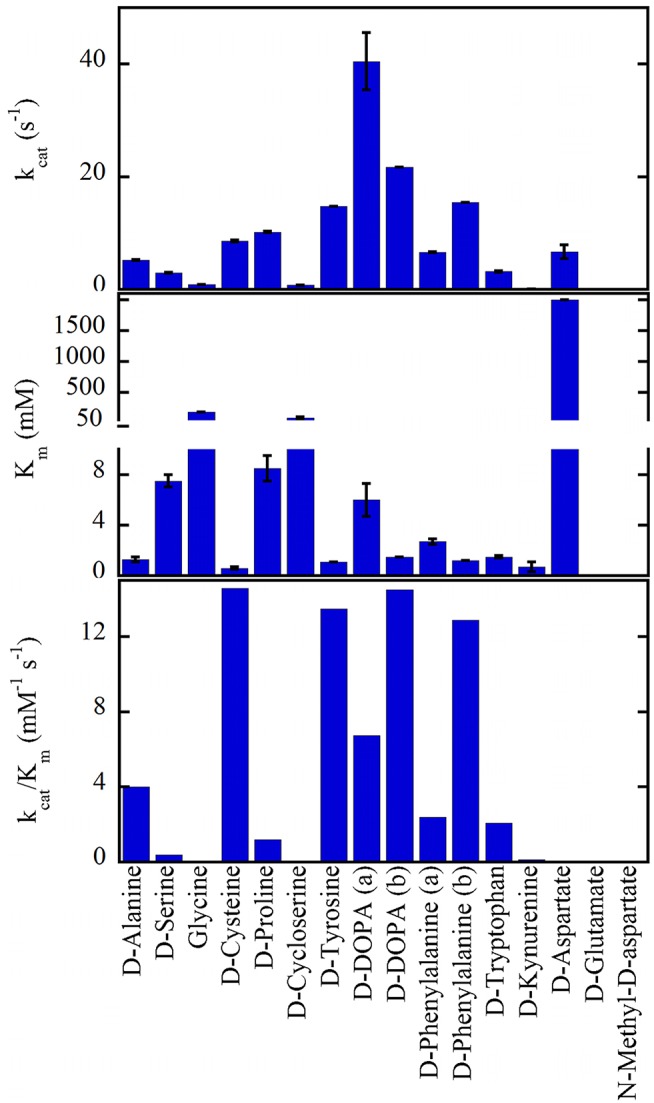
Substrate preference of hDAAO. The apparent kinetic properties have been determined at 21% oxygen saturation, pH 8.5, and 25°C. All values were from Molla et al. (2006) with the exception of (a) Murtas et al. (2017b), Frattini et al. (2011); (b) Kawazoe et al. (2007b).